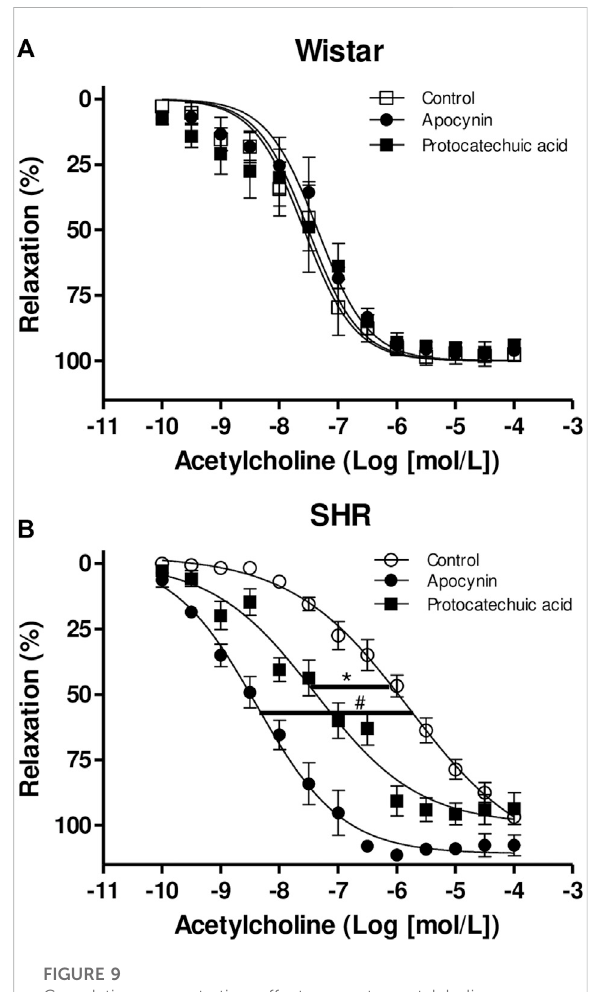
FIGURE 8 Cumulative concentration-effect curves to phenylephrine (0.1 nmol/L – 100 μ mol/L) in aorta rings from Wistar rats (A) and SHR (B) preincubated(100 μ mol/L)withapocynin(blackcircles) or protocatechuic acid (black squares) or not incubated (Control, white symbols). Values represent the mean ± SEM of the results, in percentage of contraction, n = 4 – 8. (A) * p < 0.05 pD 2 values of Control vs. Apocynin or Protocatechuic acid, & p < 0.05 Emax values of aortic rings with Apocynin vs.